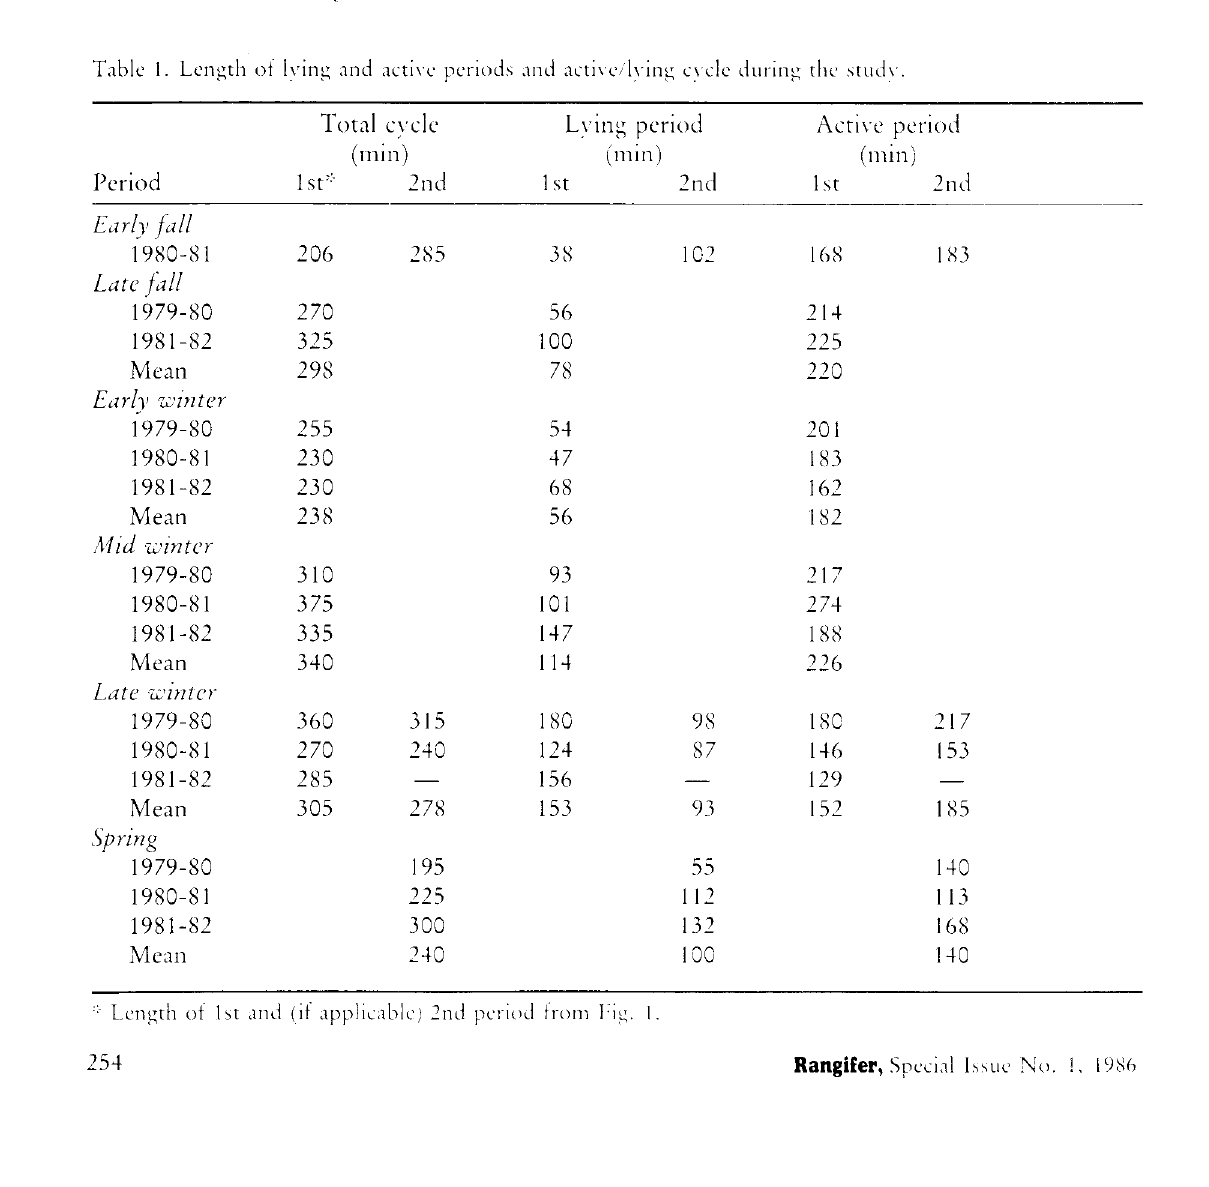
Table 1. Length of lying and active periods and active/lying cycle during the